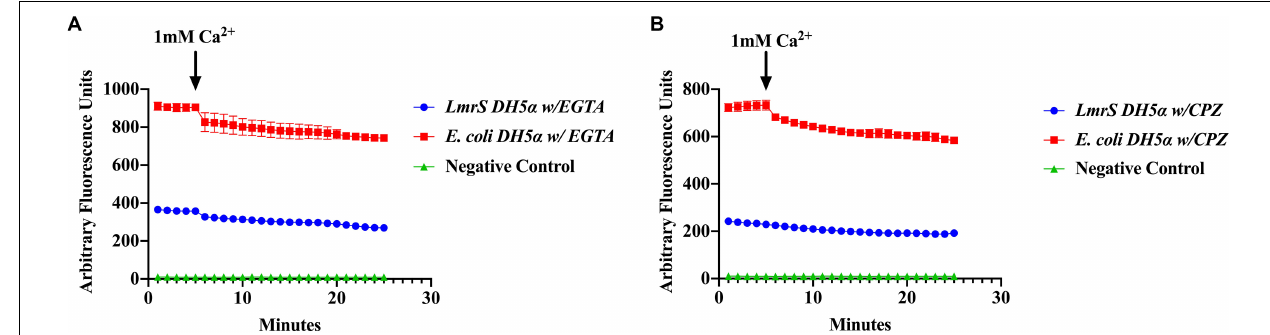
FIGURE 7 | The calcium chelator EGTA (A) and the phenothiazine chlorpromazine (CPZ) (B) inhibit efflux of EtBr by LmrS. Recombinant E. coli cells and E. coli cells without the LmrS gene (used as control) were assayed by direct EtBr assay as described in the “Materials and Methods” section. The results represent the mean of at least three biological replicates. Each time point represents the average mean ± SD. A Kruskal–Wallis test was utilized to detect significant differences between the Ca 2 + inhibitor treatments and without inhibitors. Significant differences were observed in both the E. coli DH5 α and the recombinant E. coli strain as well as significant differences in efflux between the strains ( p <